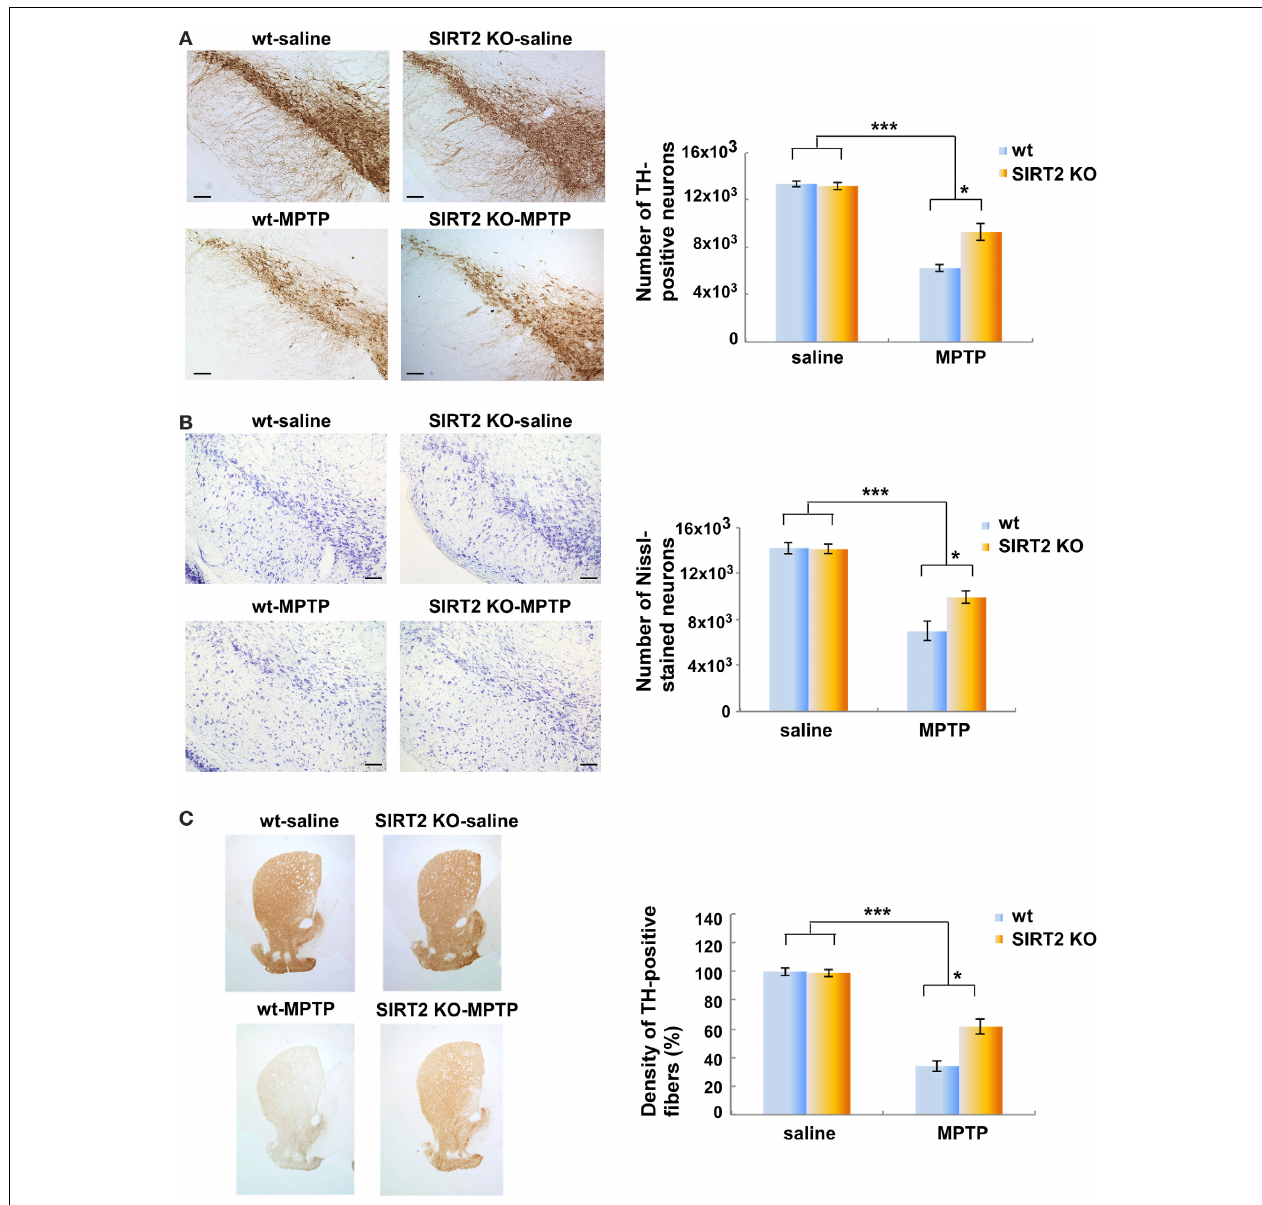
FIGURE 1 | Deletion of SIRT2 reduces the MPTP-induced nigrostriatal damage in mouse brains. (A) The left panel shows immunostaining of TH-positive neurons in the substantia nigra pars compacta (SNpc) in saline- or MPTP-dosed wt or SIRT2 KO mice. Scale bar represents 100 μ M. The quantification on the right shows the number of SNpc neurons counted by the image analysis tool of NIS-Elements AR microscope software. Bars represent s.e.m ( n = 4–5). Statistical analyses were carried out using Two-Way ANOVA. ∗∗∗ p < 0 . 001, MPTP vs. saline groups; ∗ p < 0 . 05, SIRT2 KO-MPTP vs. wt-MPTP. (B) The left panel shows the Nissl staining of the neurons in SNpc of saline- or MPTP-dosed mice. Scale bar represents